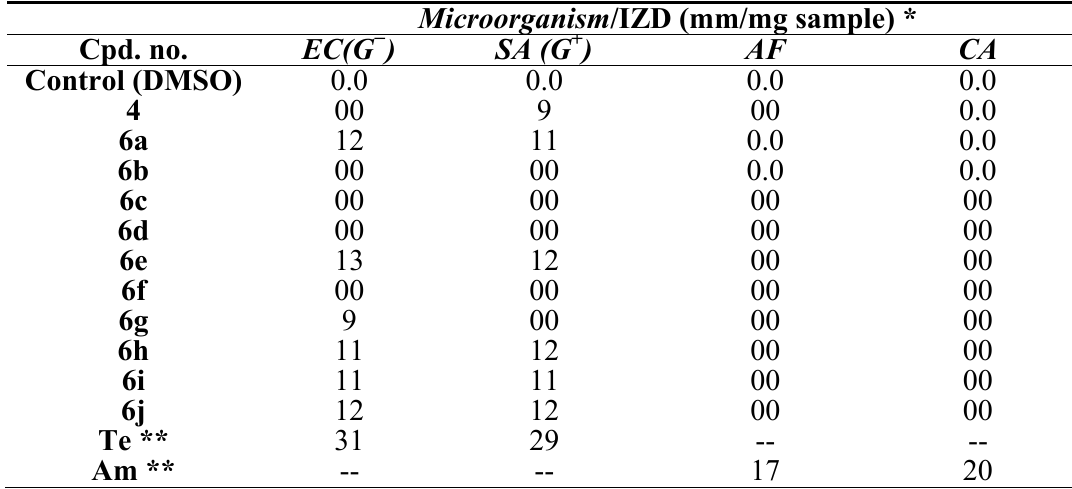
Table 2. Antimicrobial Activity of the newly synthesized